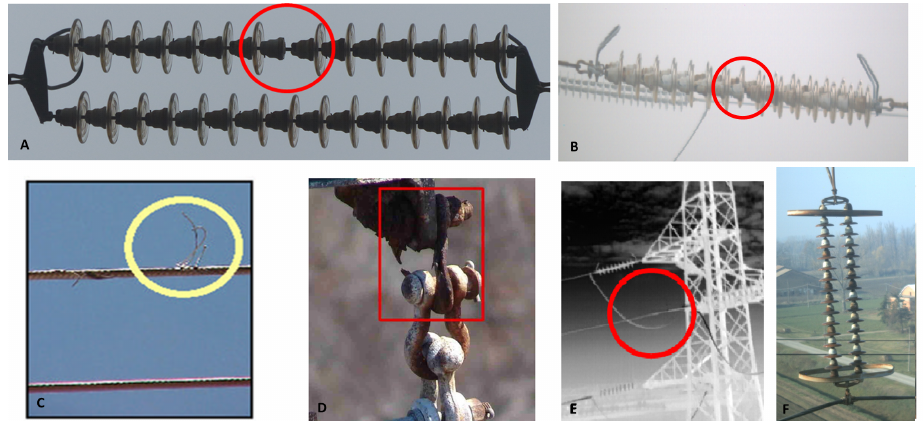
Figure 1. A sample of common defects: ( A ) missing plate along the insulator chain; ( B ) missing plate along the (rusted) insulator chain; ( C ) damaged strand of the cable; ( D ) hanging point, damaged by rust; ( E ) cable joints, which are more frequently affected by hot spots; ( F ) a chain of insulators,